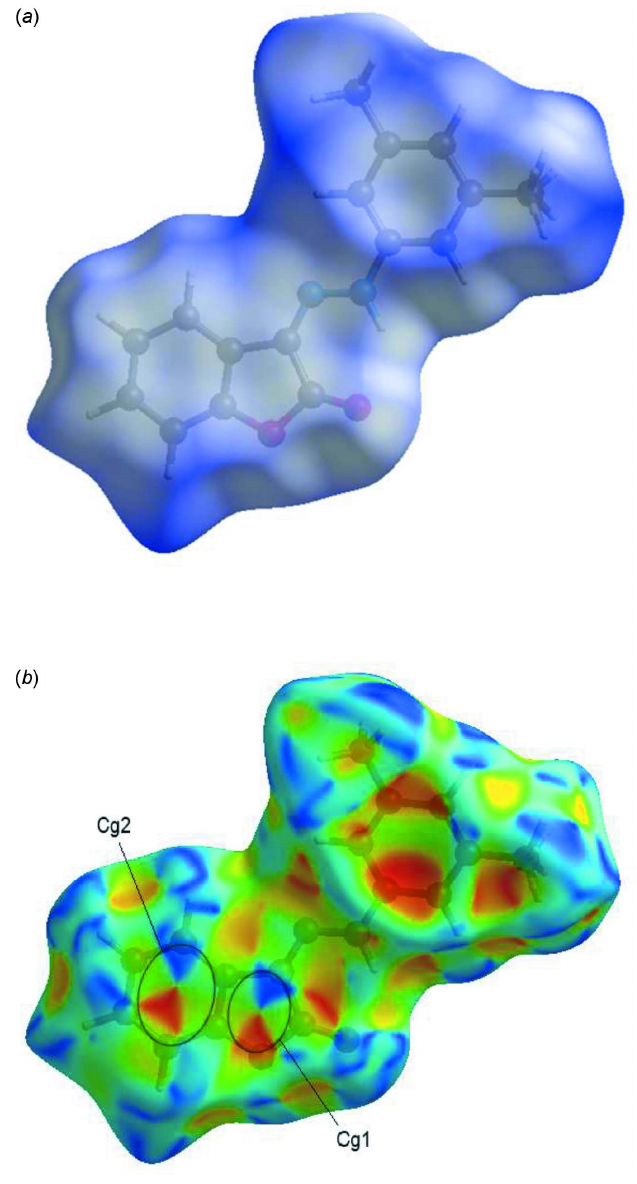
Figure 5 Hirshfeld surfaces of the title molecule, ( a ) mapped with d norm in the range (cid:4) 0.0001 to 1.5993 a.u. and ( b ) plotted over